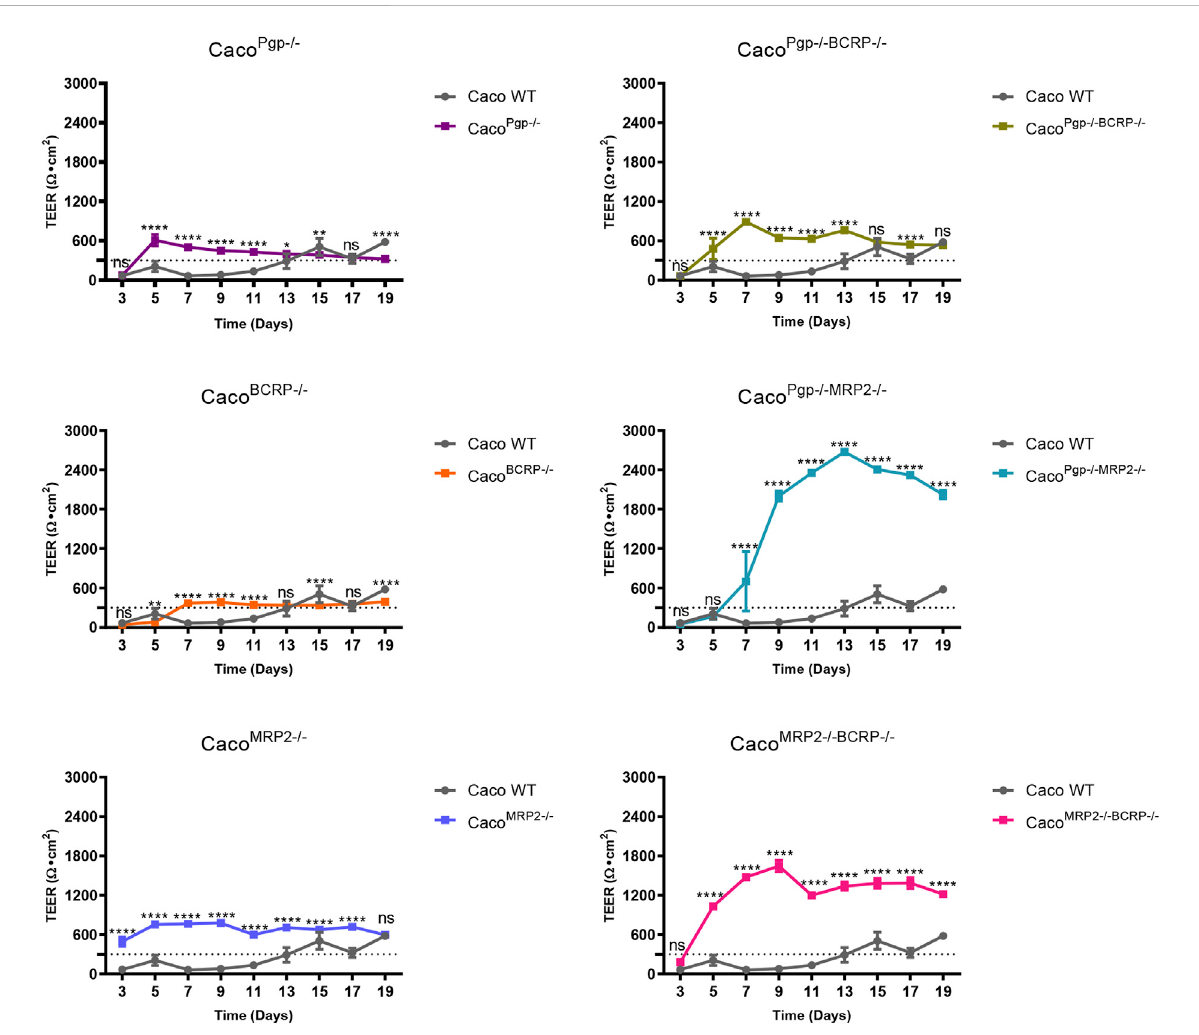
FIGURE 4 The TEER changes of each KO clone compared with the WT cell. Each bar represents the mean ± SD.; n = 5. The dotted line indicates 300 Ω · cm 2 . ns: not signi fi cant; * p < 0.05; ** p < 0.01; *** p < 0.001; **** p <